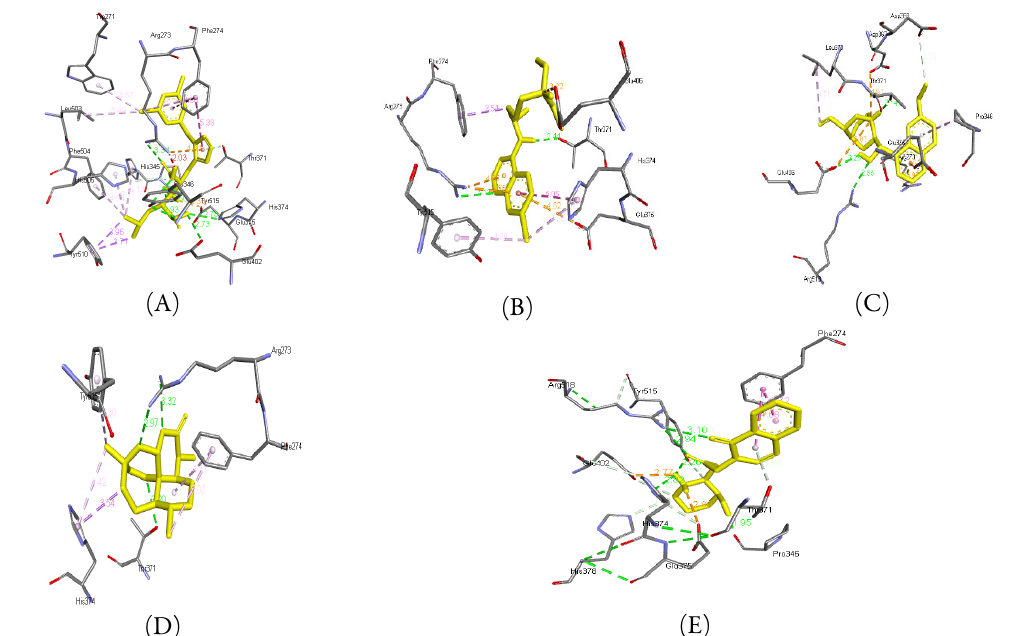
Figure 2. Depiction of 3D structures showing the interactions between the studied ligands and the receptor ACE2. A1, Interactions between the reference molecule XX5 and ACE2. B1, Interactions between Chloroquine and ACE2. C1, Interactions between Quinine and ACE2. D1, Interactions between Artemisinin and ACE2. E1, Interactions between Febrifugine and